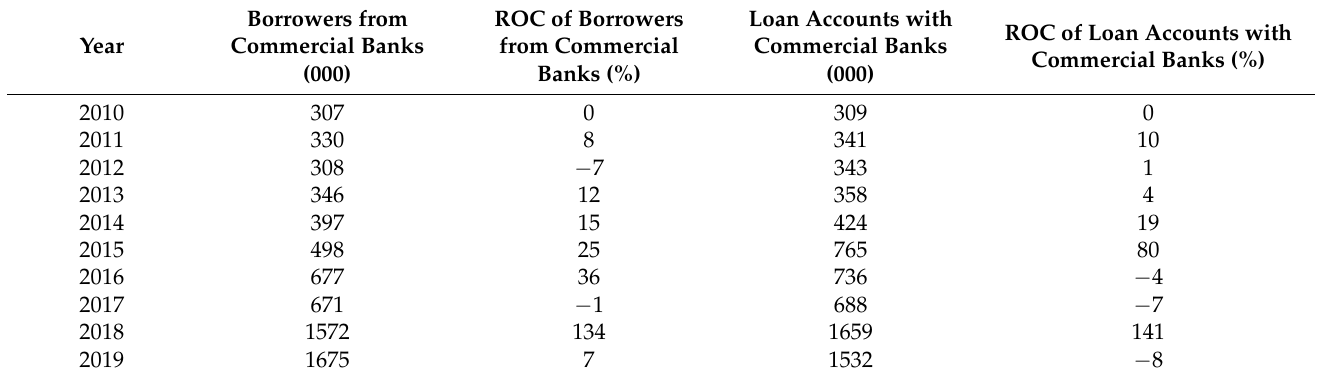
Table 4. Momentum of growth in borrowers and loan accounts with commercial bank.